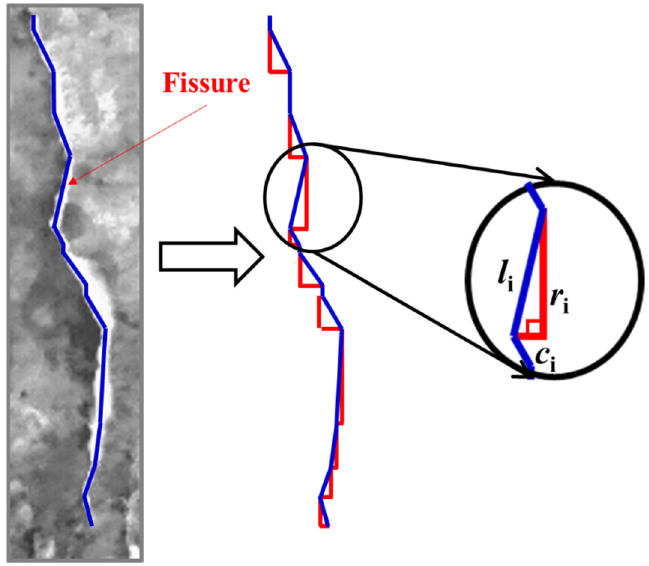
Figure 3. Schematic diagram of the method for extracting fissure length from an image.